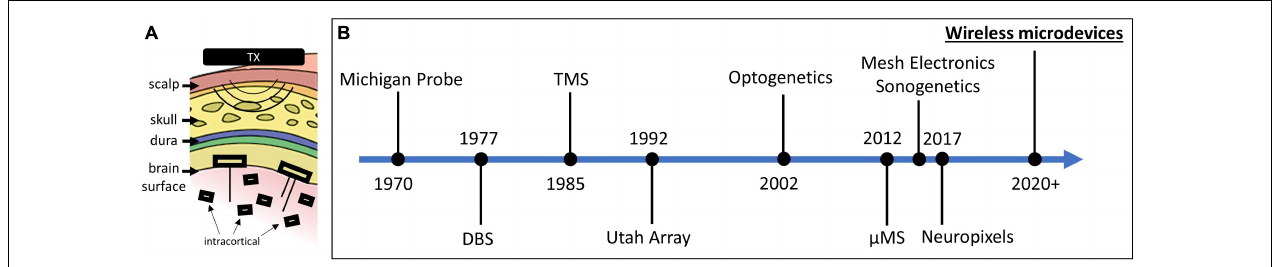
FIGURE 1 | (A) Two types of free-floating microdevices: epicortical with penetrating electrodes and intracortical. (B) Timeline showing the significant breakthroughs in the field of neural interface (interface modalities and technologies are both shown).